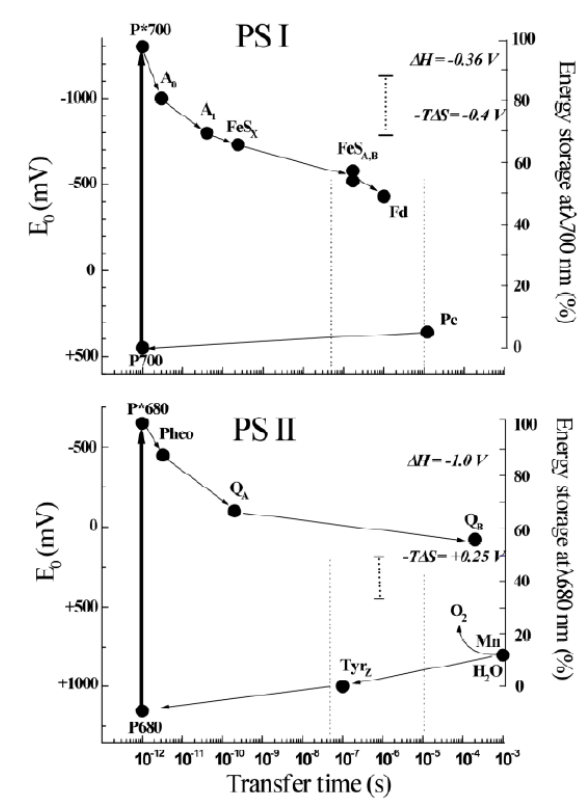
Figure 5. Energetic scheme of PS I and PS II. Dashed lines show the time window of the PA measurements (reproduced with permission from the American Chemical Society